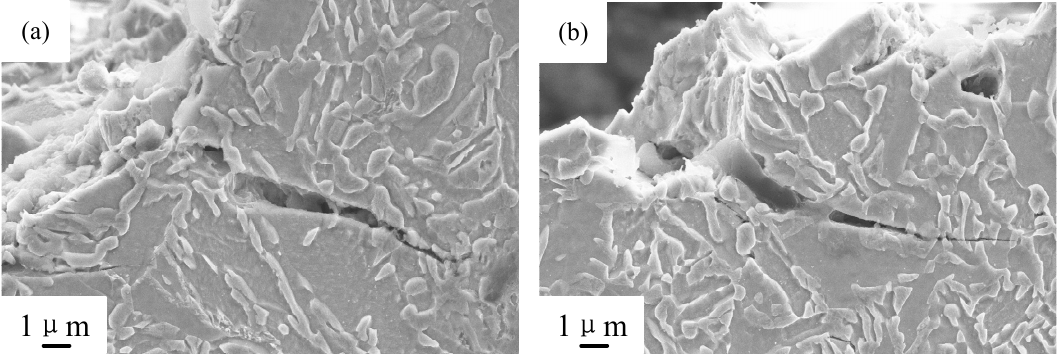
Figure 9. SEM images of the cross-sectional area of the Charpy impact specimens fractured at − 45 °C for the SA738 Gr.B steel tempered at 690 °C ( a ), 710 °C ( b ).